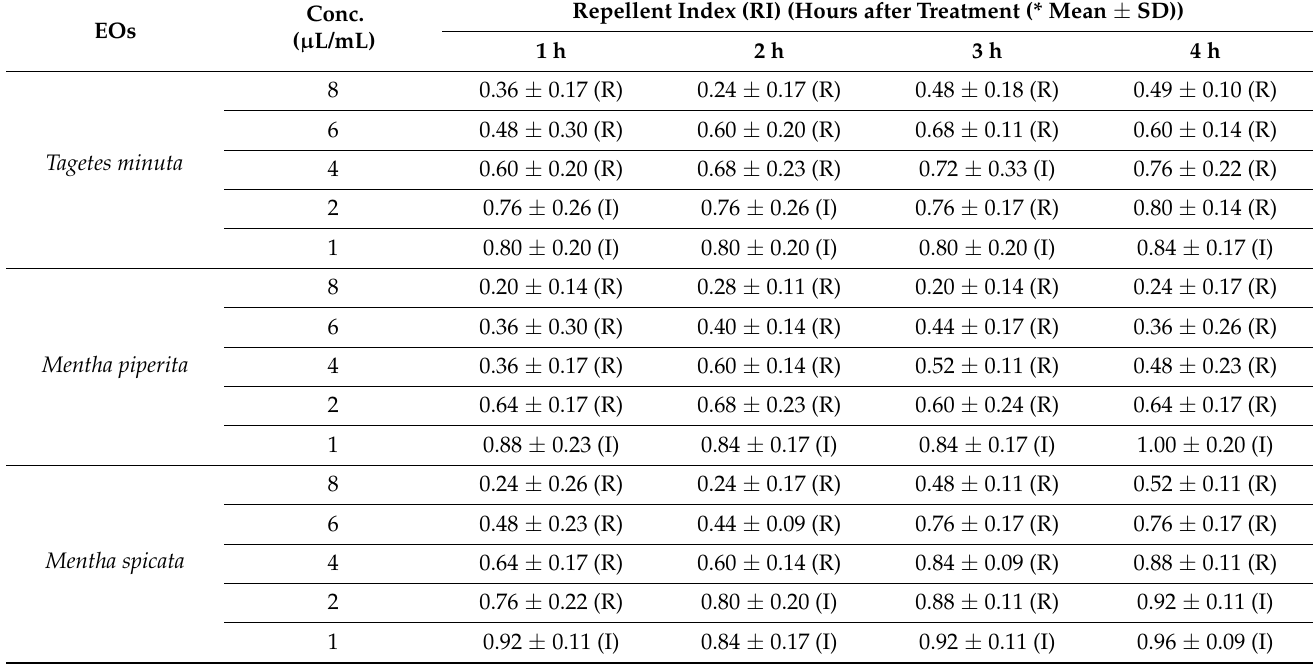
Table 5. Repellent index of essential oils against Callosobruchus maculatus